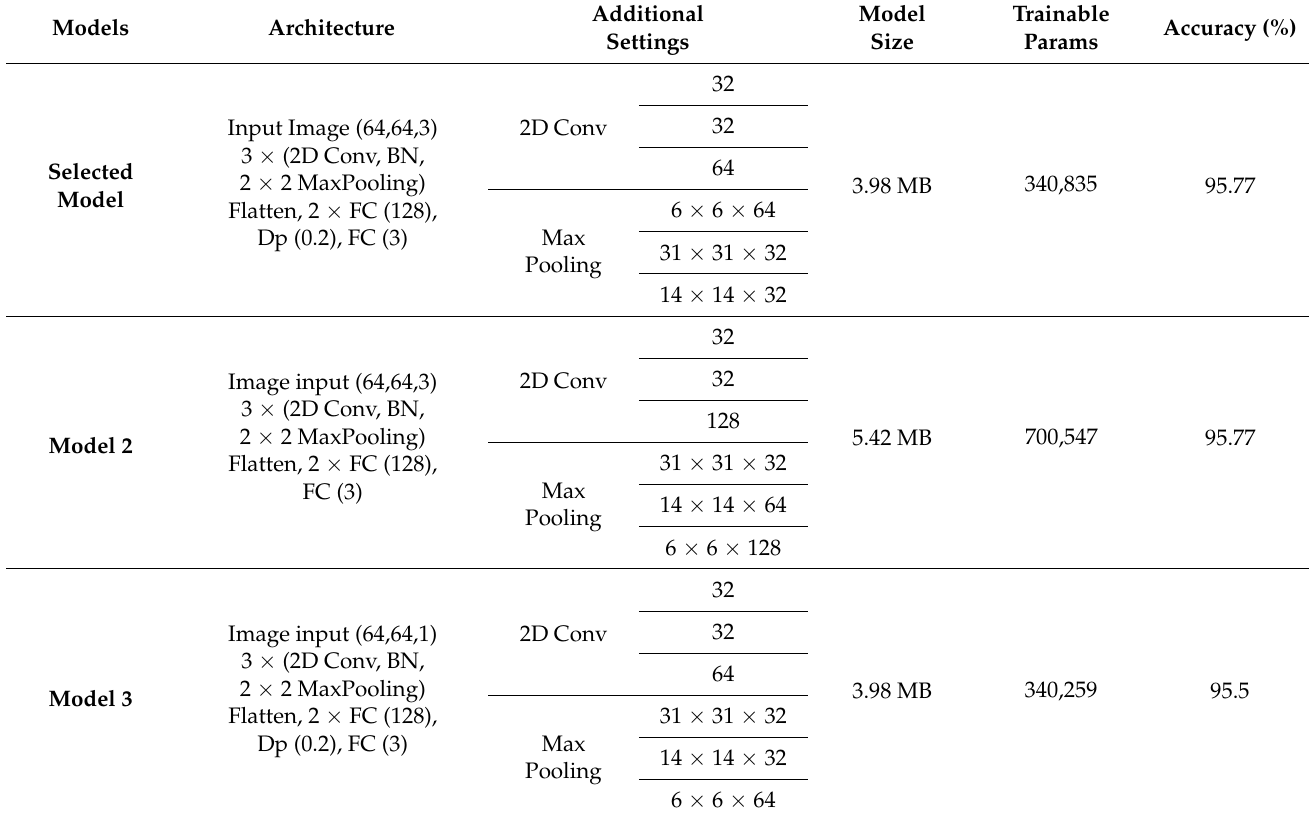
Table 3. Best three candidate configurations for the proposed S ‐ CNN.